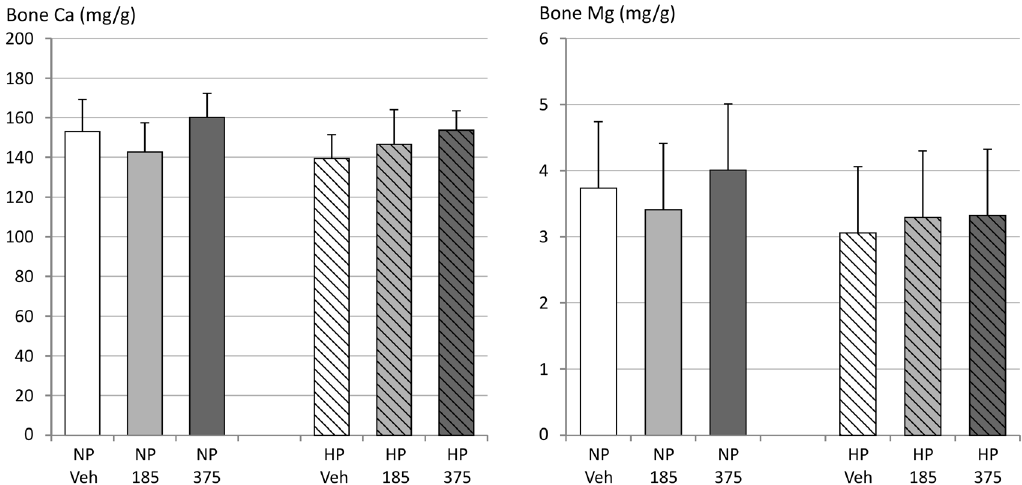
Figure 4. Calcium and magnesium content in the tibia of 5/6 th nephrectomized rats on a normal (NP) or high phosphorus (HP) diet treated with either vehicle (veh), 185 or 375 mg/kg/day CaMg.